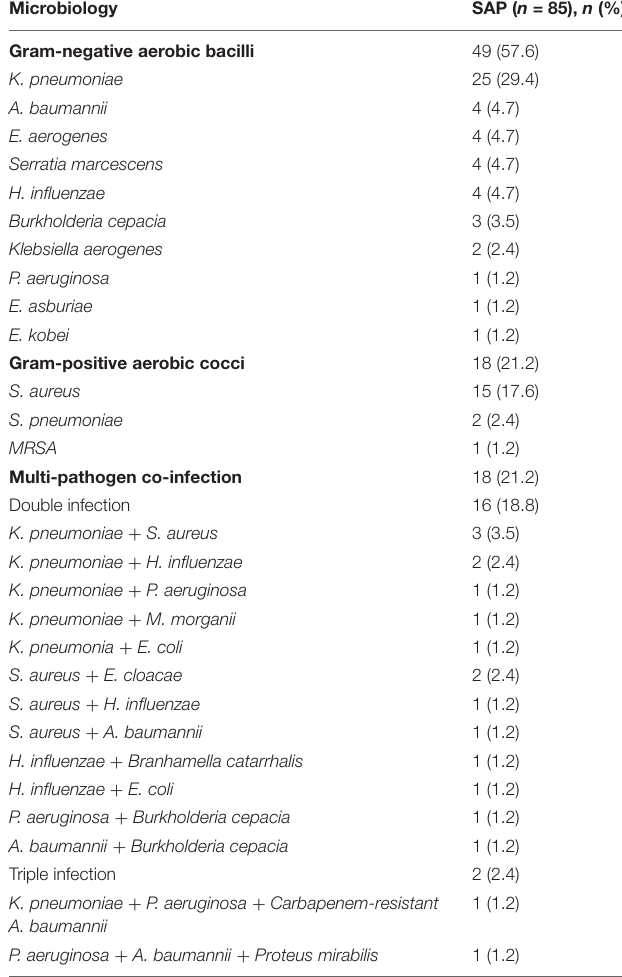
( Table 4 ). Sensitivity analysis by excluding patients treated with PAT suggested that SAP ( n = 62) had prolonged durations of MV, ICU stay, and hospital stay, and a higher 60-day mortality than non-SAP ( n = 95) ( Supplementary Table 5